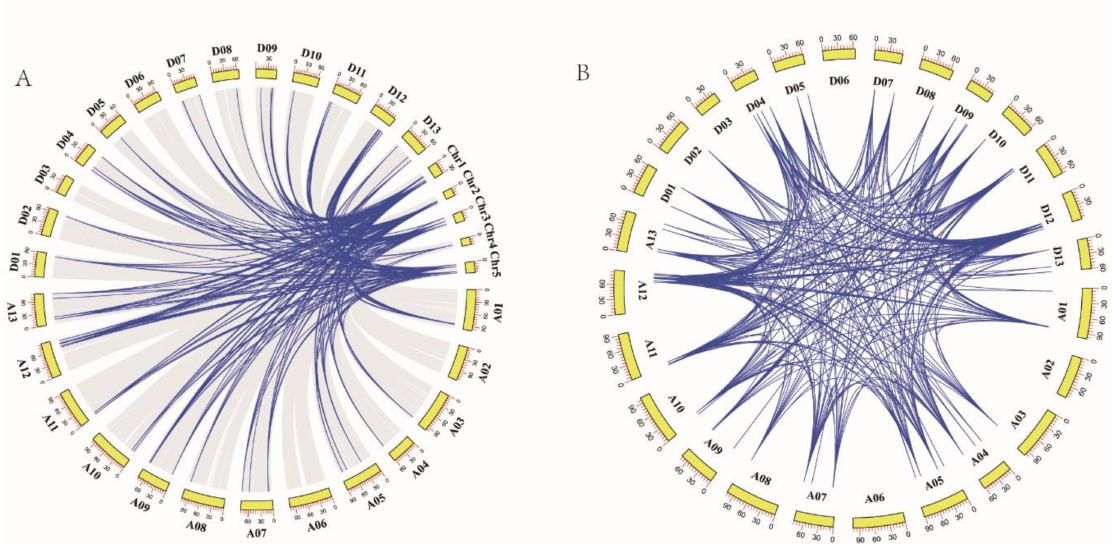
Figure 5. Synteny of TCP genes. ( A ) Synteny analysis of TCP genes between G. hirsutum and Arabidopsis . Colored lines indicate the syntenic regions between G. hirsutum and Arabidopsis chromosomes. ( B ) Chromosomal distribution and synteny analysis of cotton TCP genes. The chromosomal positions of cotton TCP genes were identified. Colored lines connecting two chromosomal regions indicate the syntenic regions of the cotton